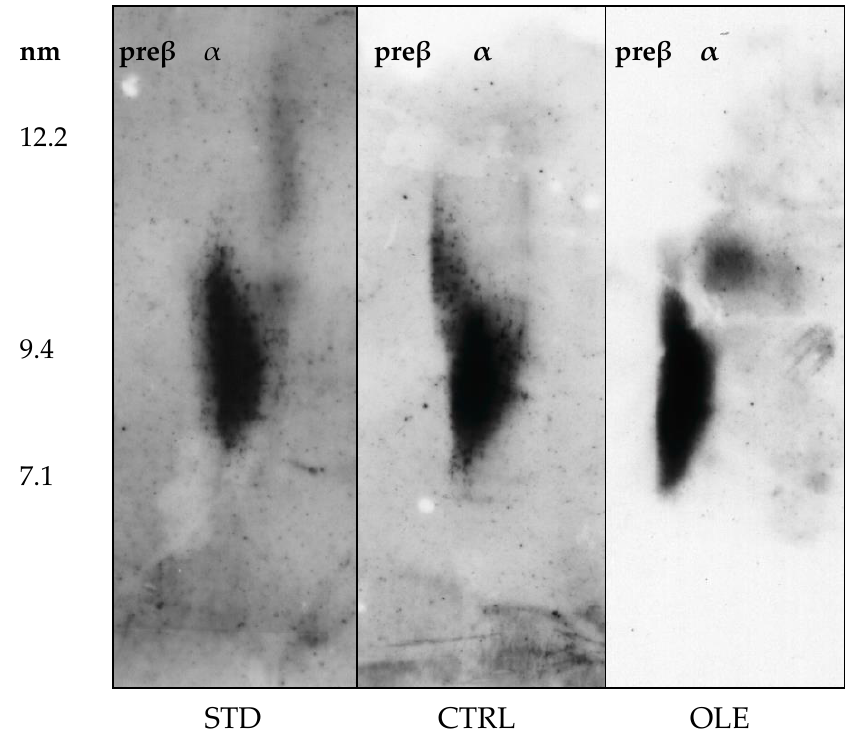
Figure 5. Plasma HDL characterization of hamsters: HDL subclasses were separated by 2D electrophoresis then transferred onto a nitrocellulose membrane, on which lipoproteins were detected with an anti-murine apoA-I antibody. Plasma from four STD, four CTRL and nine OLE were evaluated; images are shown for one representative sample for each group. α , specific sub-population of HDL. When compared to the CTRL group, the high fat diet induced a slight reduction of HDL size that was even more evident in animals treated with OLE